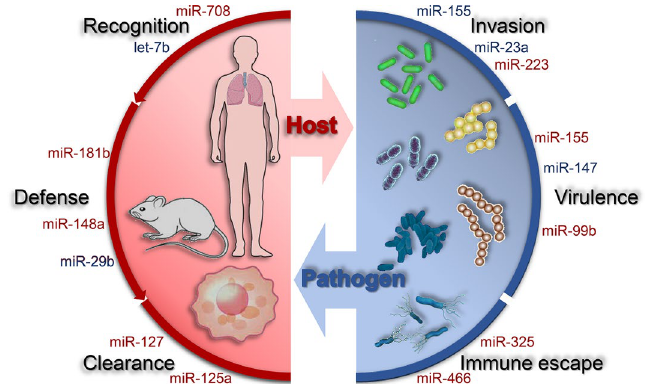
Fig. 3 The interactions between the host and the pathogen. As a part of host innate immunity and adaptive immune response, pathogen infection is neutralized by miRNAs by regulating the recognition of the pathogen, the defense against it, and its clearance. At the same time, miRNAs can inhibit the host immune response and induce host infection by enhancing the invasion of pathogens, moderating the virulence of pathogens, and aiding their immune